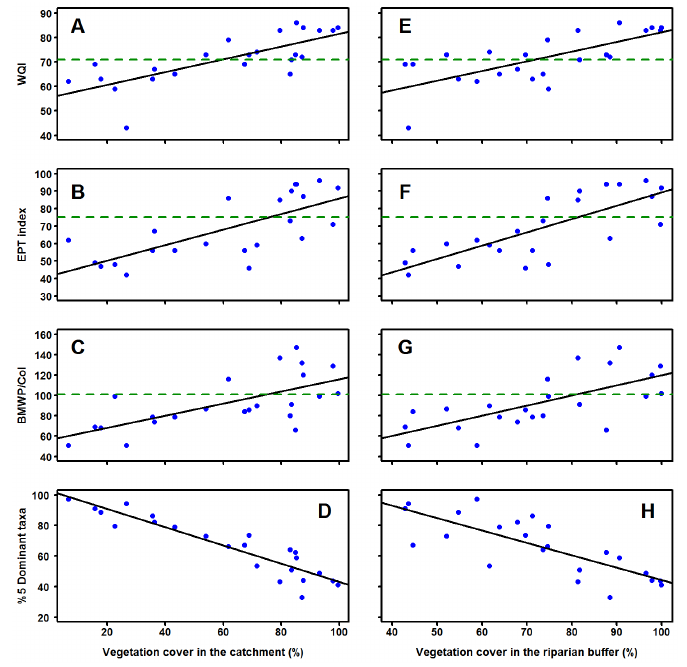
Figure 2. Water quality indices plotted against vegetation cover (%) at catchment and buffer scales. Horizontal green dashed lines represent thresholds of good water quality defined for each metric in the literature. Only the %5 Dominant index does not have ranges of tolerance, but high percentages indicate stress in the communities. For both spatial scales R 2 values are over 0.44 with a p –value , 0.001, see Table 2 for specific values of each regression.